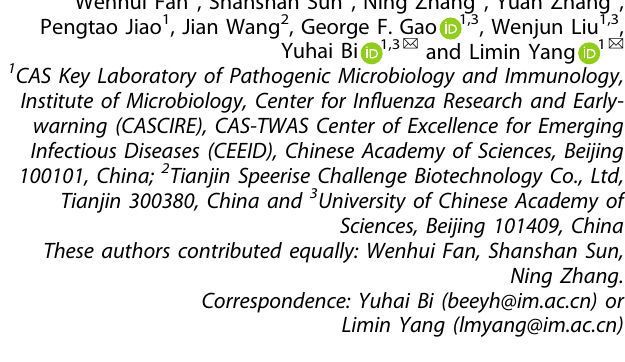
Fig. 1 Protection of yolk antibody (IgY) against SARS-CoV-2 challenge in mice. a Flow chart of experimental design for preparing the SARS- CoV-2 speci fi c yolk antibodies. Solid vertical lines indicate weeks of immunization, and egg symbols indicate sampling time points. b , c The humoral response dynamics of immunized laying hens were monitored. SARS-CoV-2 speci fi c binding antibodies were assessed by ELISA. Neutralization activity with live SARS-CoV-2 (WT) was assessed as EC 50 by observing the cytopathic effect (CPE). Dotted lines indicate the detection limit. See also supplementary Fig. S1a. d Neutralization of the Wuhan-Hu-1 (WT), Beta, Delta, and Omicron variants of concern (VOCs) by the second boost IgY antibodies were measured by a recombinant lentiviral-based pseudovirus neutralization assay. Sera from three volunteers who had received two doses of inactivated vaccines (Sinopharm) were collected and assayed simultaneously. See also supplementary Fig. S1b, c. e Flow chart of the experimental design for protective testing of the developed IgY antibody. Mice were intranasally (IN) transduced with 8 × 10 9 virus particle (VP) of Ad5-hACE2 followed by nasal delivery of antibody or PBS-placebo. They were then challenged with SARS-CoV-2 and euthanized at 3 days post-infection for viral load titration and pathological evaluation. Solid lines indicate the timeline of antibodies delivery IN (black), challenge (red), and sacri fi ce (green). f , g Viral loads in lung and trachea tissues were measured by qRT-PCR. h Lung virus titers were detected by TCID 50 assay in Vero E6 cells. i H&E staining of the representative lung tissue sections. Scale bars are 50 μ m. See also supplementary Fig. S2. j Immuno fl uorescence staining detection of the SARS-CoV-2 S protein. Scale bars are 50 μ m. Data were shown as mean ± SEM. An unpaired t -test was performed to test statistical signi fi cance between the group receiving the IgY antibody and the placebo group (** P < 0.01; **** P <